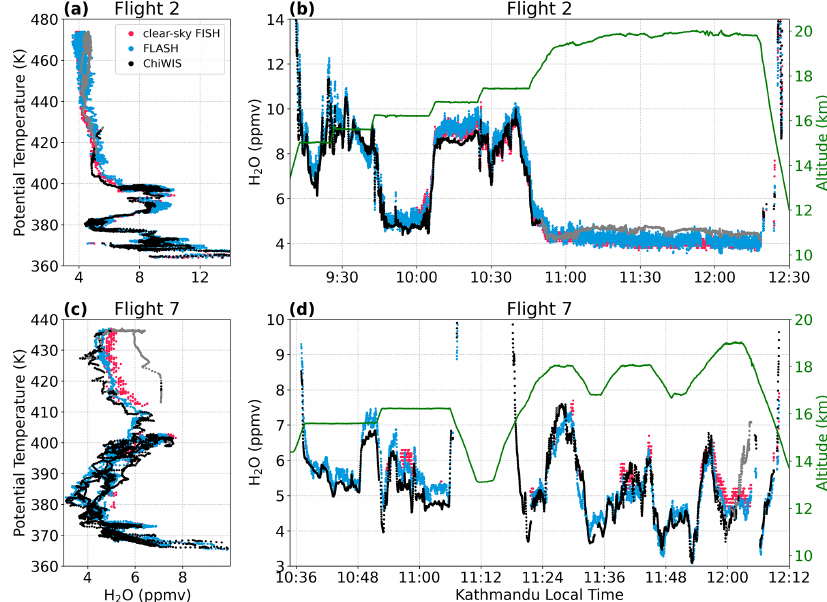
Figure 6. Vertical profiles (a, c) and time series (b, d) of water vapor from F2 (a–b) and F7 (c–d) . Due to differing flight strategies on F2 and F7, vertical range is smaller for F7; panels (c–d) show more detail. Altitude (green) and in situ H 2 O measurements from ChiWIS (black/grey), FLASH (blue), and clear-sky FISH (pink). Periods where ChiWIS cell pressure is just out of regulation, between 20 and 30mbar, are excluded from the intercomparison but shown in grey for reference. Note, this was common during the later parts of F2–F4 and F8 when the aircraft flew long level flight legs at nearly 20km. Across both of these example flights, there is impressive agreement between the three hygrometers, to the point that it is difficult to even pick out the FISH measurements plotted beneath the other two. The higher precision of ChiWIS creates sharper apparent temporal structure in the time series (b, d) . Nevertheless, all three instruments are able to capture fine-scale variability in atmospheric water vapor. F2 (a–b) shows an example of two very wet layers ( ∼ 10ppmv) above the cold-point tropopause (CPT) around 390 and 399 K with agreement between the three hygrometers about the magnitude and spatial variability of these layers. F7 (c–d) shows an example of variability of H 2 O around the CPT, with mixing ratios ranging from 3–7.5ppmv related to passage through cirrus clouds.